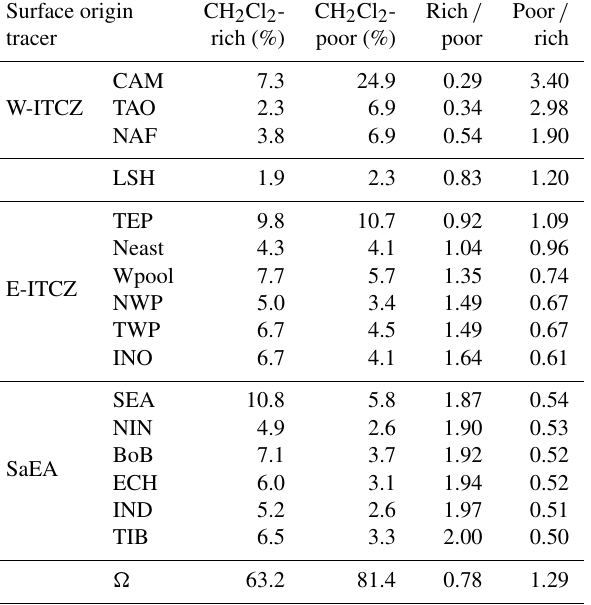
Table 1. Median fractions of different surface origin tracers from CLaMS in measurements of CH 2 Cl 2 -rich and CH 2 Cl 2 -poor air parcels and the respective ratios of the median fractions. The last row shows the median fraction of (cid:127) . (cid:127) is the sum of all (non- normalized) surface origin tracers of the respective air parcels ( (cid:127) = (cid:80) n = 24 (cid:127) i ; see Sect. 2.3.1), which is the fraction of an air par- i = 1 cel actually considered in the tracer analysis of CH 2 Cl 2 -rich and CH 2 Cl 2 -poor air. The fraction (100 − (cid:127) )% is the part of an air par- cel that was already in the free atmosphere on 1 May 2017. The geographical location of each surface origin tracer is given in Fig. 2.